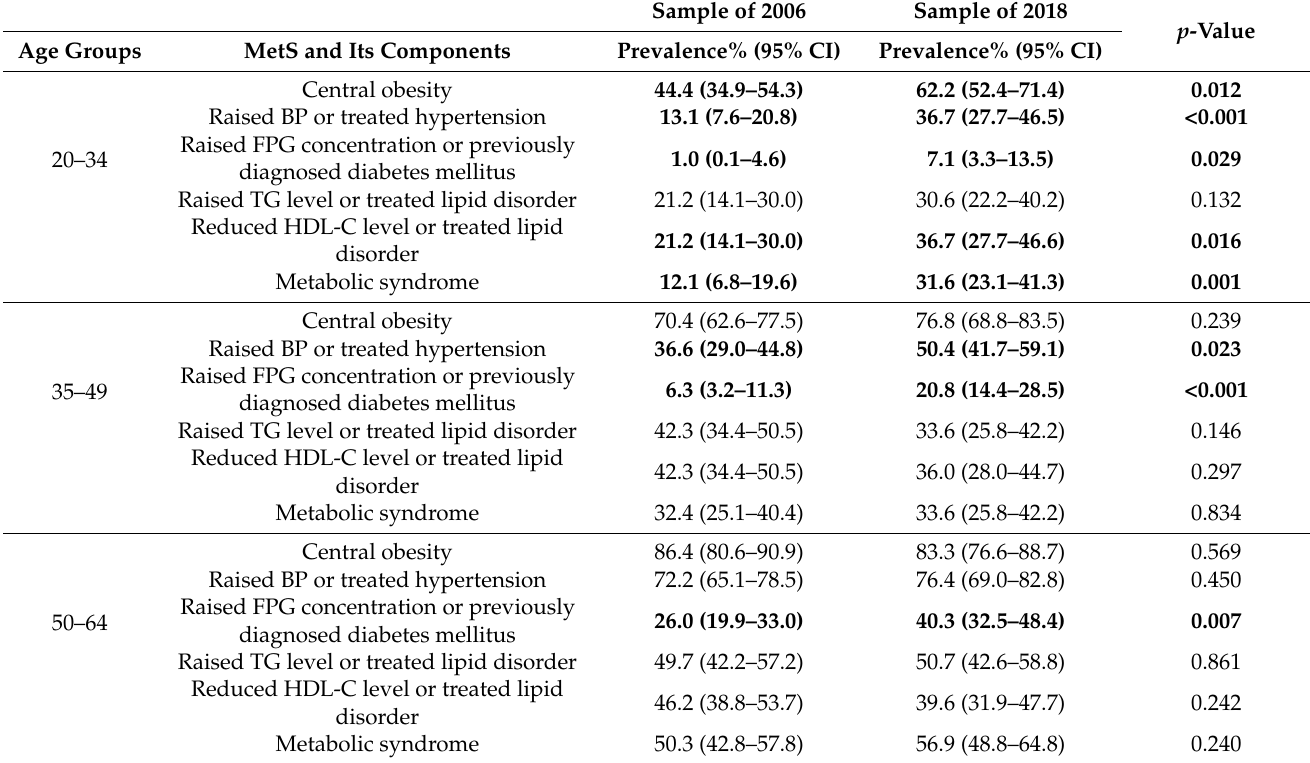
Table 3. Change in prevalence of metabolic syndrome and its components by age group in the Northeast Hungarian population from 2006 and